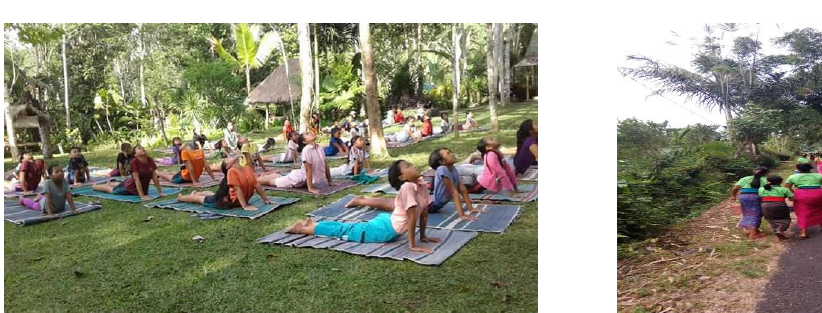
Figure 3 Hindu Teenage of Figure 4 Hindu teenager goes to family‟s home who performed the Yadnya Dewa